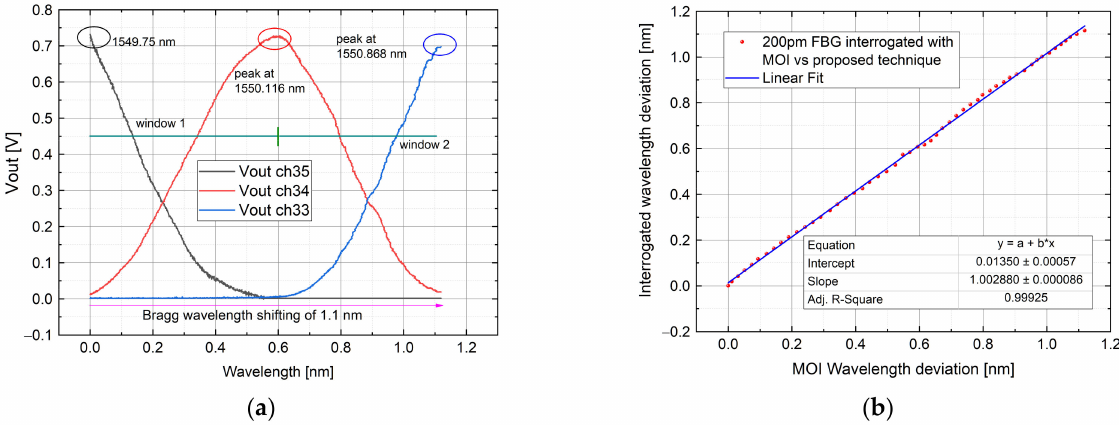
Figure 8. A 200-pm bandwidth FBG sensor was interrogated among AWG channel 35, 34 and 33. The figure shows: channel output voltage ( a ); interrogated wavelength with a commercial system vs. proposed one compared with a linear fit in a dynamic range of measurement of 1.1 nm ( b ). The starting Bragg wavelength position is more than 400 pm over the Ch35 peak.